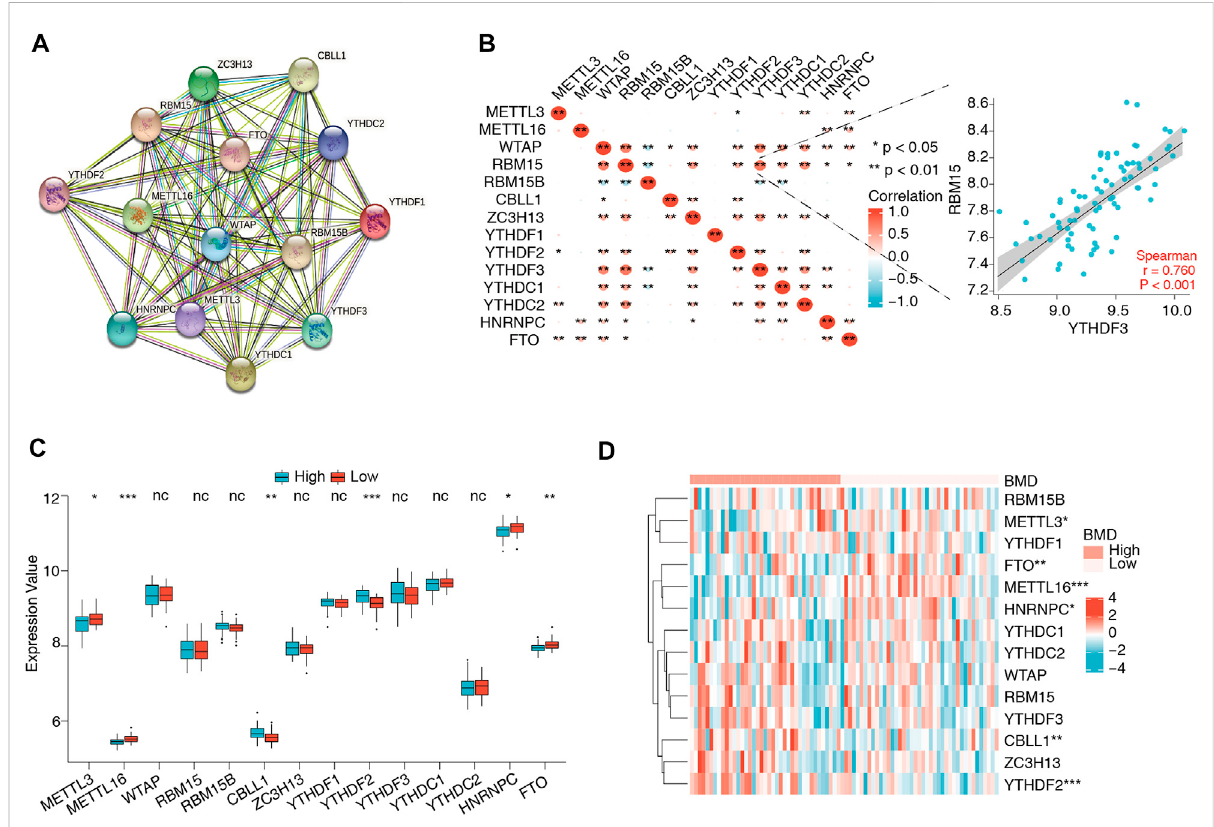
Expression and correlation of 14 m6A regulators in osteoporosis. (A) Protein – protein interactions of 14 m6A regulators. (B) Expression correlationsofthe14m6Aregulatorsinallsamples.Thedepthofthecolorblockrepresentsthelevelofthecorrelationcoef fi cient,and*denotesthe signi fi cance of the statistical analysis. The most correlated gene pair was YTHDF2 and RBM15 , the expression status of which is presented in the scatter plot in the right panel. (C,D) The box plot and heatmap plot show the summary of 14 m6A regulators between the high- and low-BMD groups, and six m6A regulators ( METTL3 , METTL16 , CBLL1 , FTO , YTHDF2 , and HNRNPC ) were signi fi cantly